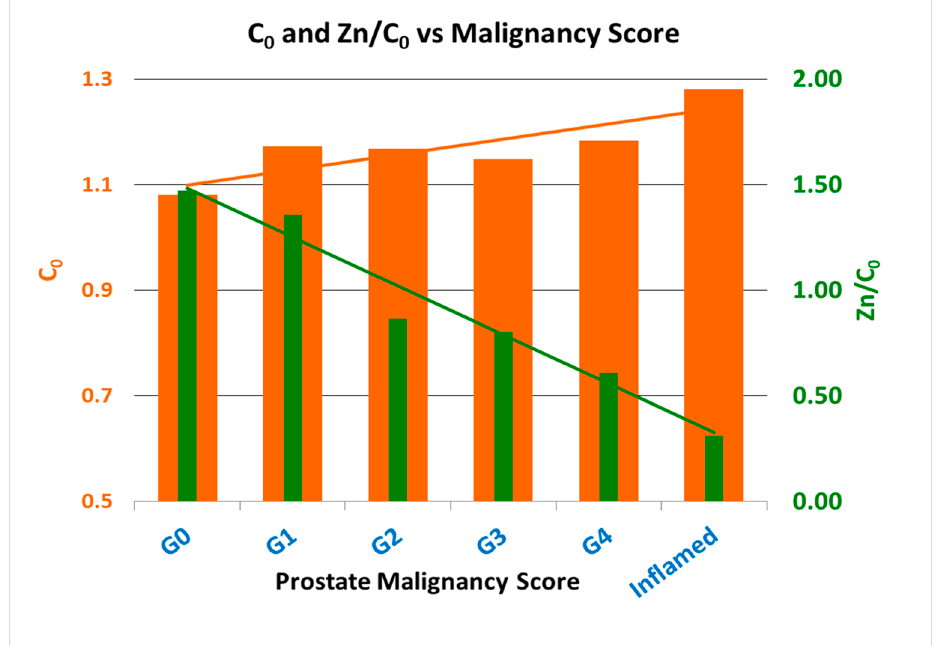
Figure 3. Prostate malignancy scores as a function of the prostate levels of C 0 (tissue proliferation) and Zn/C 0 (Zn depletion). No G5 prostates were found in this study. There is a strong and evident differentiation between the XRF levels of C 0 , and Zn/C 0 characteristics for high-PCa-malignancy-score prostates and those for benign or low-malignancy-score prostates. The levels of these parameters are also dependent